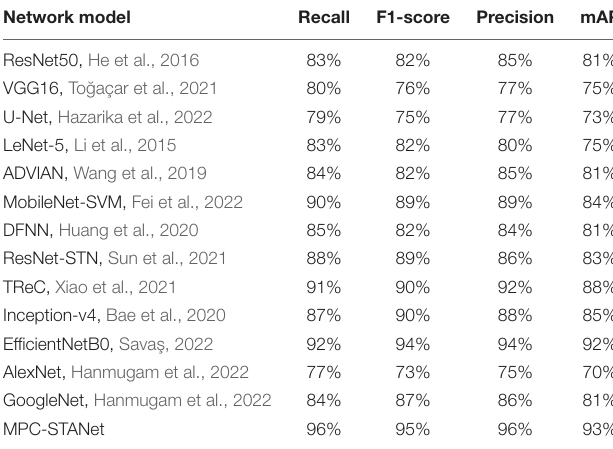
TABLE 7 | Evaluation indexes of the